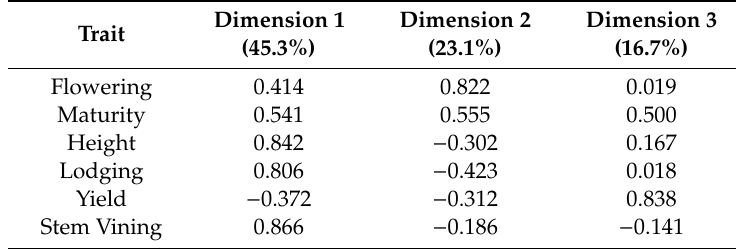
Figure 3. Multiple factor analysis (MFA) of phenotypic variation and correlation. The two-dimensional correlation structure among the 115 BC2F6 RILs is demonstrated by MFA. Dimension 1 is represented by the horizontal axis and Dimension 2 is represented by the vertical axis. The blue arrows represent the strength of trait association within a dimension. Dimension 1 accounts for 45.26% of the total variation, and Dimension 2 accounts for 23.13% of the total variation. Table 1. Eigen vectors of the first three dimensions of variance for each trait identified in multiple factor analysis (MFA) of phenotypic variation and correlation (Figure